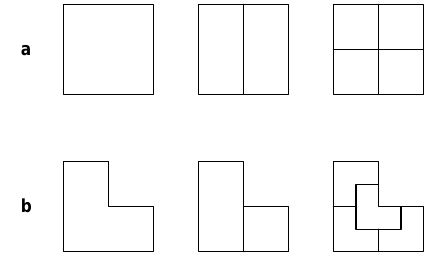
Figure 1. Decomposed domains for two different geometries.